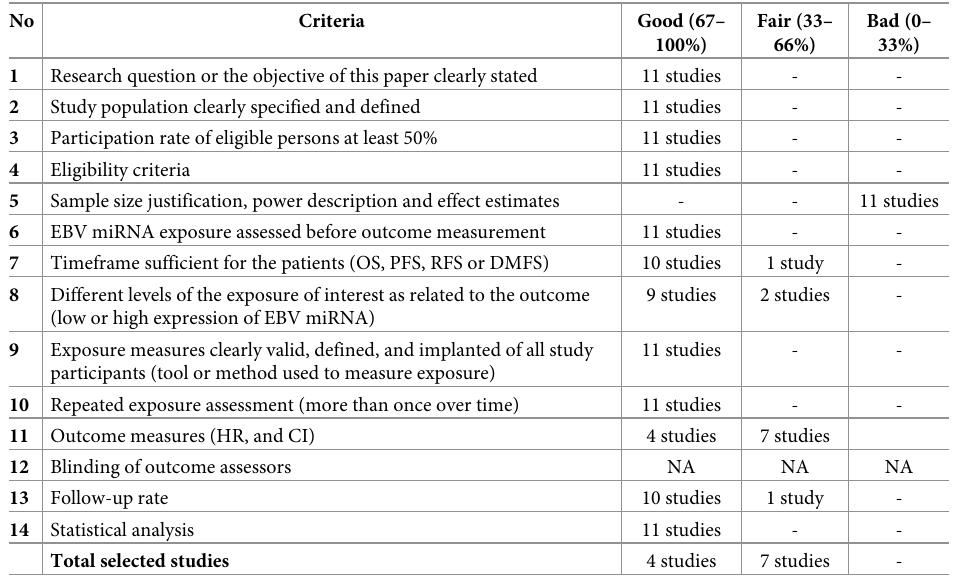
Table 3. Selected studies’ quality assessment based on criteria of quality assessment. No Research question or the objective of this paper clearly stated